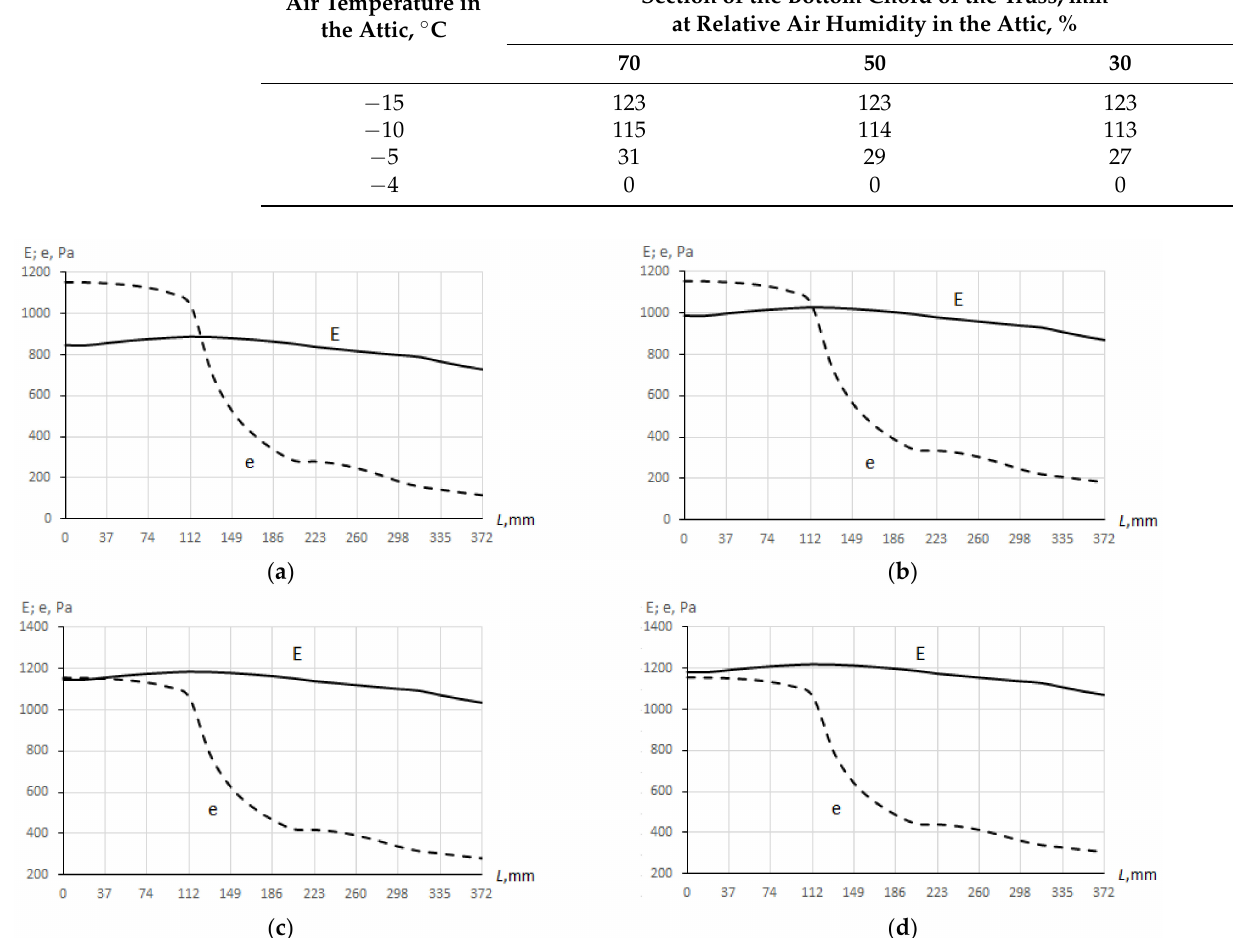
Figure 11. Graphs of changes in the partial pressure of water vapor e and partial pressure of saturated water vapor E in the area of metal structures that are not in contact with the attic air at a relative humidity in the attic of 70% and its temperature: ( a ) − 15 °C; ( b ) − 10 °C; ( c ) − 5 °C; and ( d ) − 4